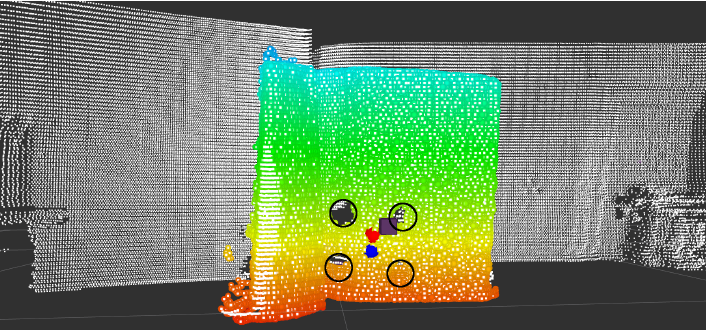
Figure 11. The blue sphere represents the lidar center position point; the brown cube represents the radar center position point; and the red sphere represents the aligned radar point. The colored pointcloud is the board’s parallel plane